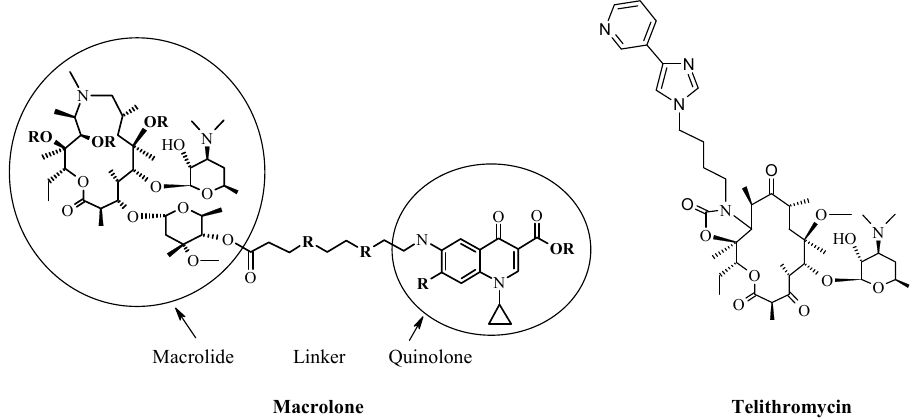
Figure 3. Schematic presentation of a macrolone molecule with its distinct moieties—macrolide, linker, and quinolone ( left ); and most common chemical modification and variation positions are marked with “R”. The structure of telithromycin, the first ketolide antibiotic clinically used to treat community-acquired pneumonia of mild to moderate severity ( right ).